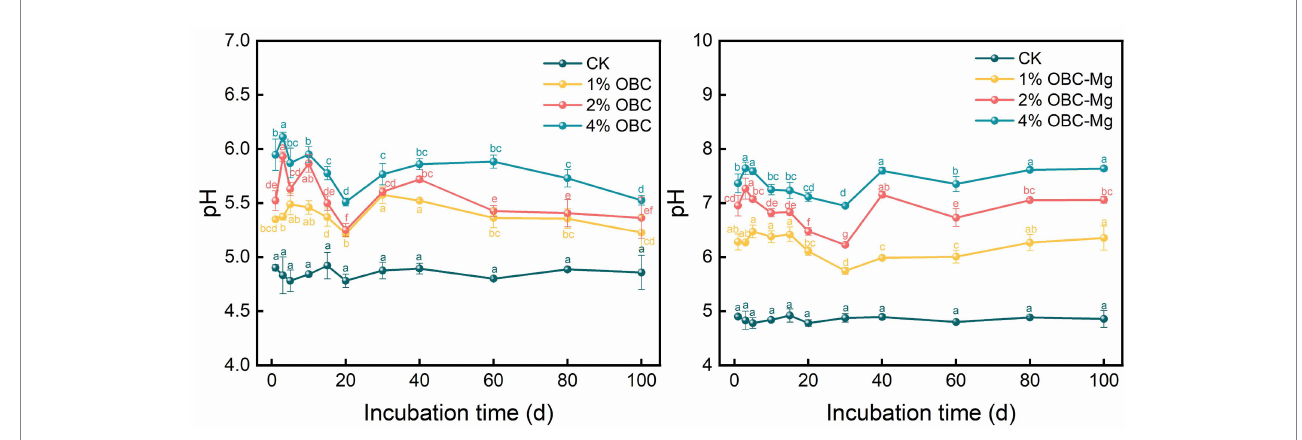
FIGURE 2 Changes in soil pH after the amendment of OBC and